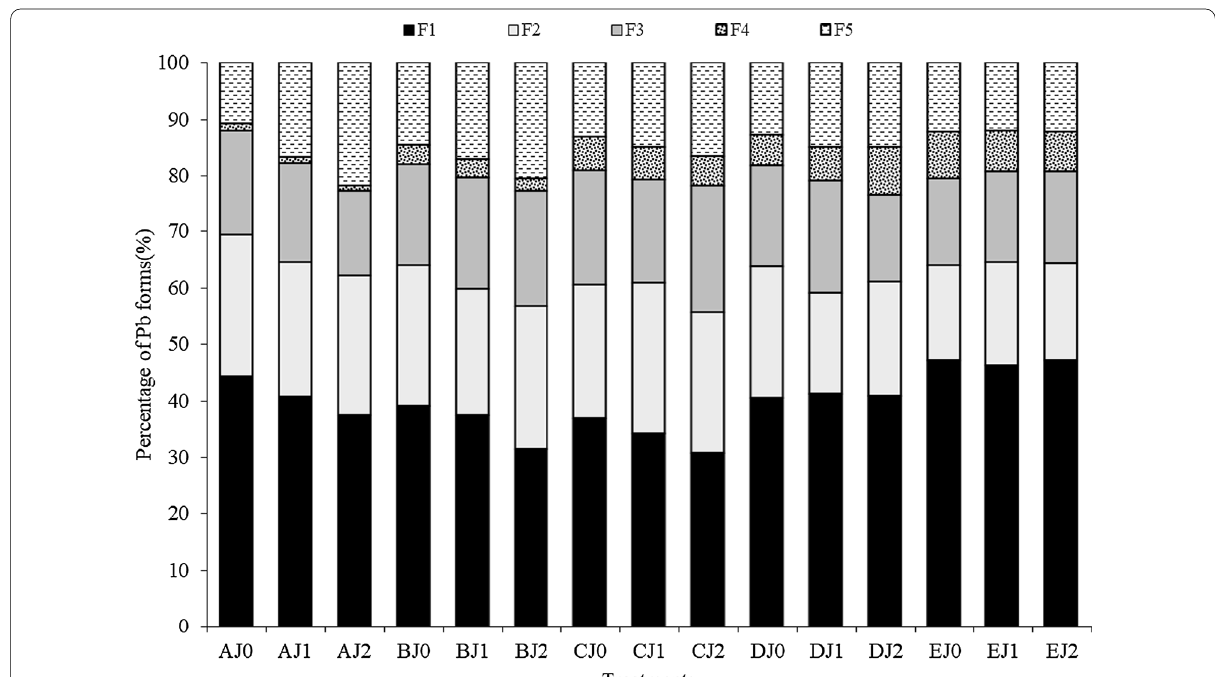
Fig. 1 Proportion of each form of Pb in rhizosphere soil after 60 days of planting in Sedum alfredii Hance. This figure represents the distribution of each form of Pb in the rhizosphere soil of Sedum alfredii Hance at harvest. AJ0 represents Cd7Pb 100 mg/kg, 0 mL of bacterial suspension; AJ1 represents Cd7Pb 100 mg/kg, 100 mL of bacterial suspension; AJ2 represents Cd7Pb 100 mg/kg, 200 mL of bacterial suspension. The rest is the same. F1, F2, F3, F4, F5 are different forms of Pb, exchangeable, bound to carbonates, bound to Fe–Mn Oxides, bound to organic matter,